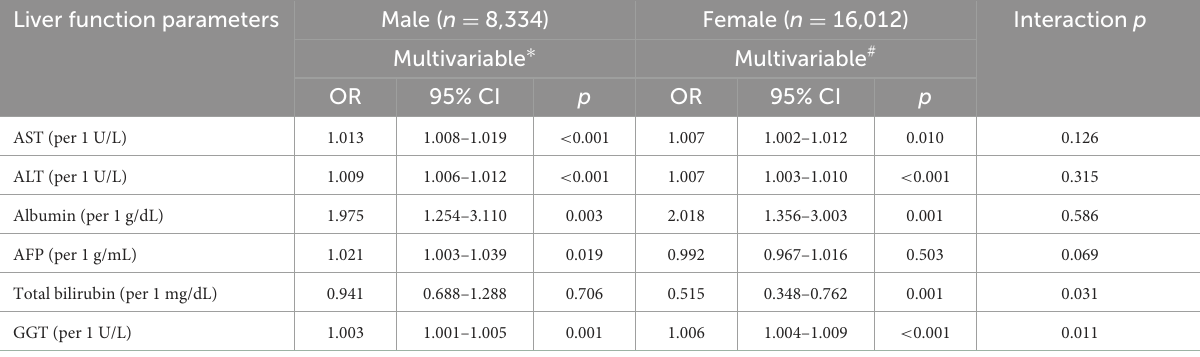
TABLE 3 Association of liver function parameters with incident DM using multivariable logistic regression analysis in different sex.